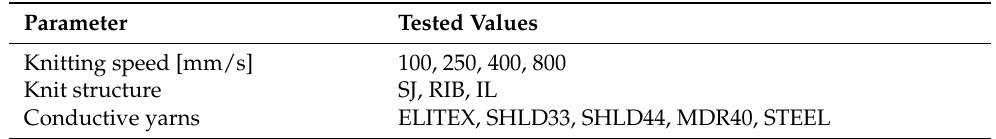
Table 2. Varied parameters for the parameter